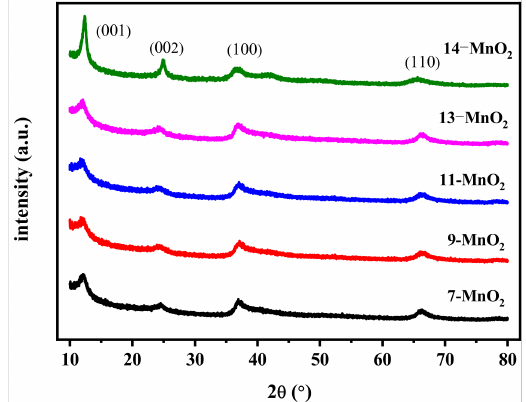
Figure 3. XRD patterns of the catalysts.